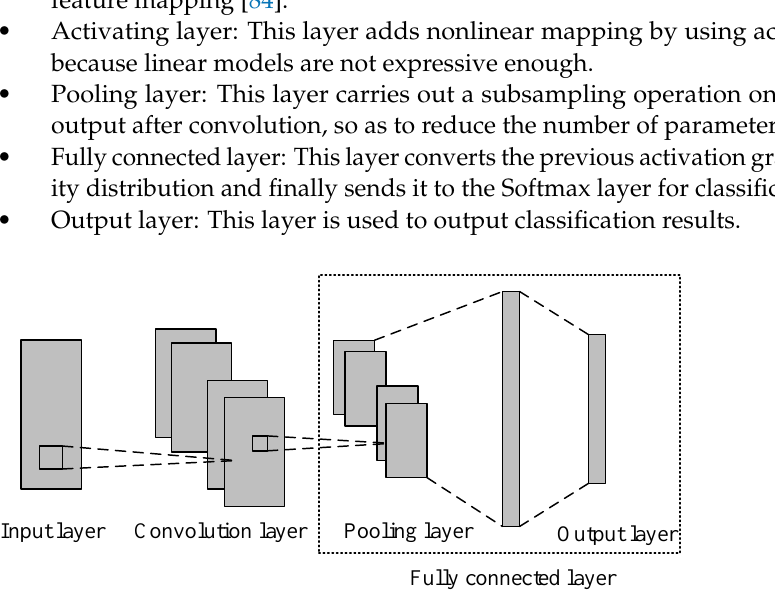
Figure 1. Typical CNN